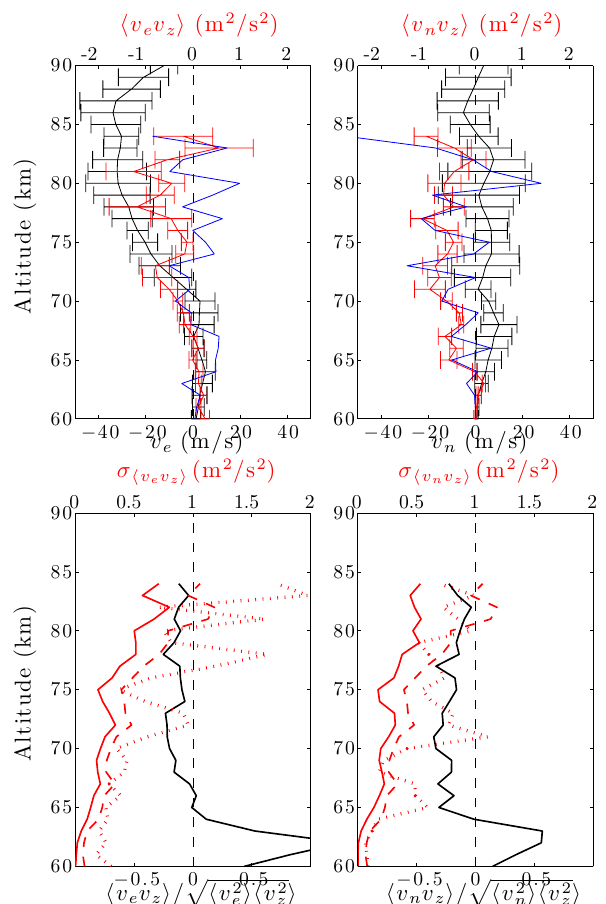
Fig. 9. Average momentum flux results from 13:00–24:00UT on 23 April 2008. Top: Zonal (left) and meridional (right) wind (black lines) with error bars corresponding to the standard deviation of wind variation over the 11-h period. Red lines correspond to the averaged vertical flux of horizontal momentum in the zonal (left) and meridional (right) directions, with error bars corresponding to the standard error on the mean for the 11-h period. Blue lines correspond to the solution including only the variance terms. Bottom: Fraction of variance embodied in the momentum flux (black lines), averaged over the 11-h period, in the zonal (left) and meridional (right) directions. Red lines correspond to errors on the momentum flux estimates determined from the fitting algorithm averaged over the 11-h period (solid), average minimum error estimate using the geometric mean of the horizontal and vertical wind variances (dashed), and standard deviation of the data over the entire time period